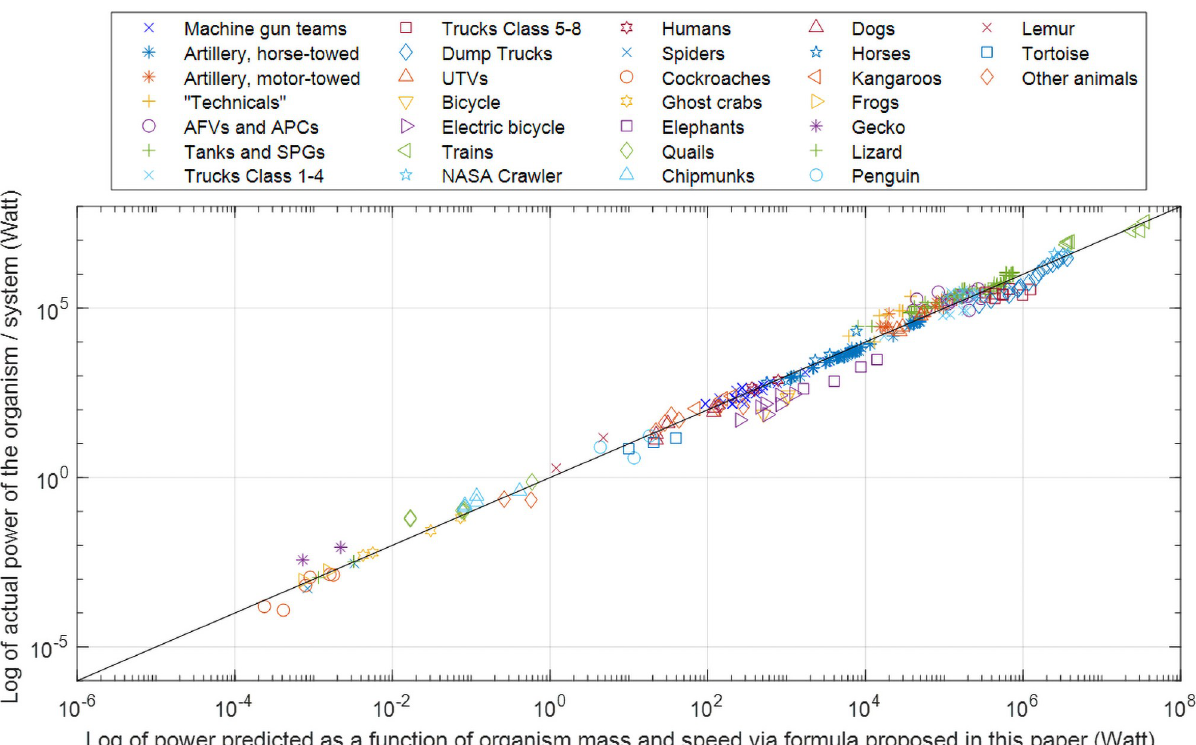
Fig 3. Comparison of actual measured or specified power vs. mechanical power predicted by Eq (2). The diagonal line illustrates the close agreement of predicted vs. actual values. For the entire set of organisms and systems, R2 is 0.987.